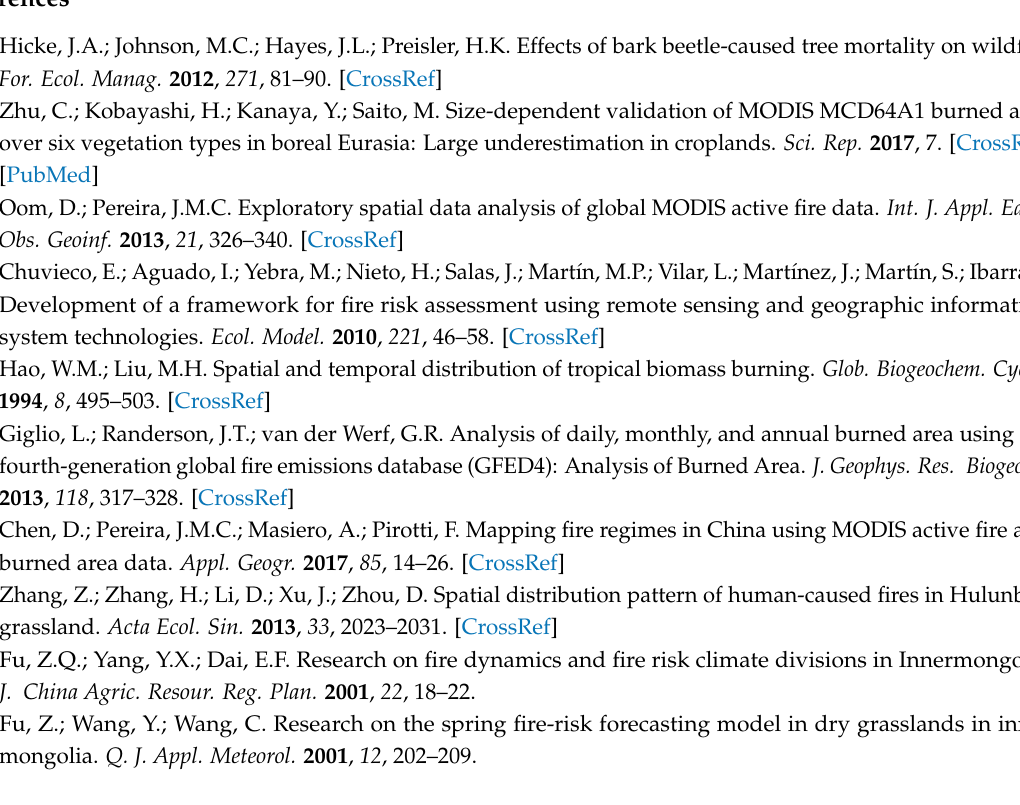
Figure S1: Trends of snow depth over the period of 1979–2012, 2013–2018 in the study area, Figure S2: 16 stations Morlet wavelet of snow depth in Hulnbuir during 1979–2018, Table S1: Trends and Hurst exponents of 16 climate stations snow depth over the period of 1979–2018 and the forecasts and trends in